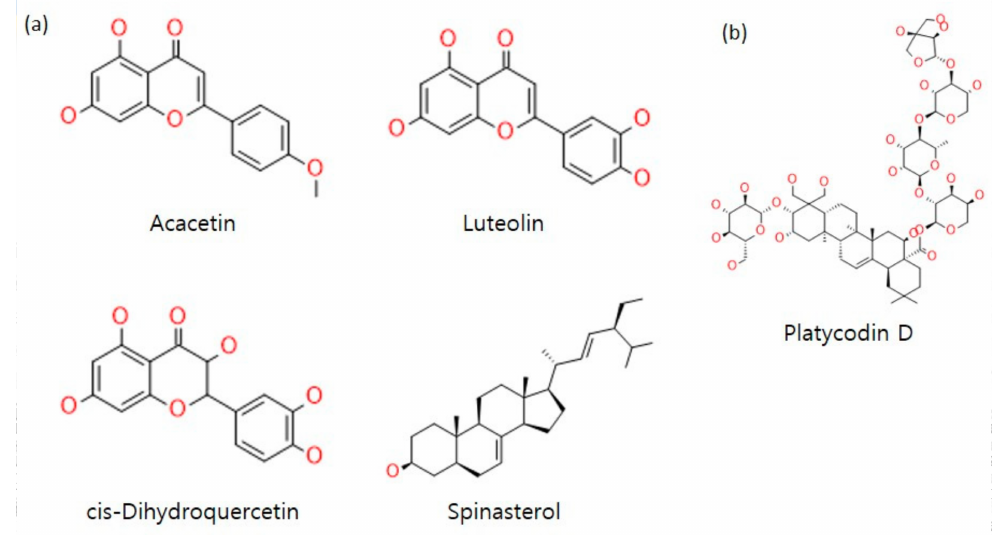
Figure 2. Chemical structures of PG compounds. ( a ) Four components of PG were selected from the TCMSP database with threshold values of 30 and 0.18 for OB and DL, respectively. ( b ) Platycodin D is a major active component of